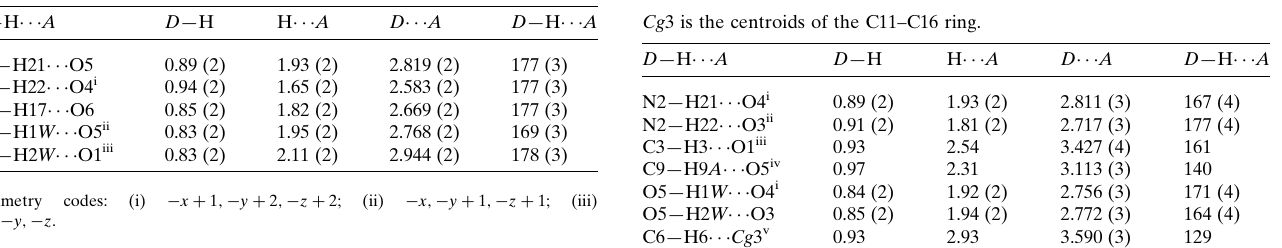
(III) are linked through strong O—H (cid:2) (cid:2) (cid:2) O and N—H (cid:2) (cid:2) (cid:2) O hydrogen bonds, forming chains along the [011] direction (Fig. 9 a , Table 3). These chains are further linked via the water molecules and C9—H9 A (cid:2) (cid:2) (cid:2) O3 interactions, generating a three-dimensional supramolecular architecture along the a axis (Fig. 9 b ). The structure of (IV) is constructed from double